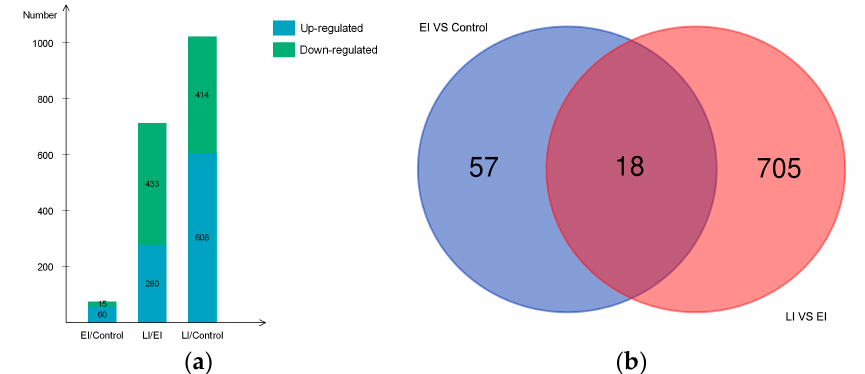
Figure 2. Differentially expressed proteins between the early and late stage ( a ). Bar chart showing the number of up- and down-regulated proteins in each of the pairwise comparisons: EI/Control, LI/EI, and LI/Control. green color indicates down-regulated proteins and blue color indicates up-regulated proteins. Overlaps among differentially expressed proteins (DEPs) between the early and late stage ( b ). Venn diagrams depict overlap of DEPs from each pairwise comparison between the timepoints, EI/Control (early) and LI/EI (late).